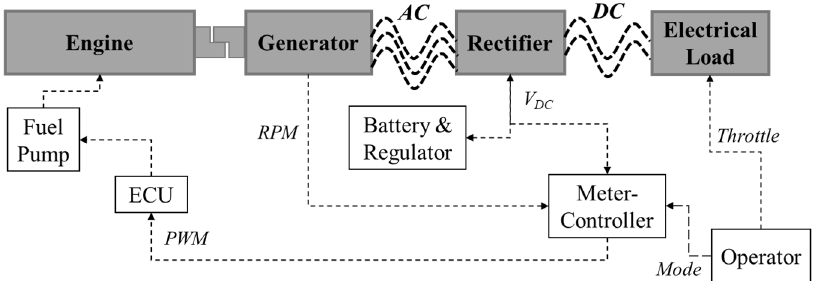
Figure 2. A basic schematic of the turboelectric system. The meter-controller determines the throttle sent to the turbine.